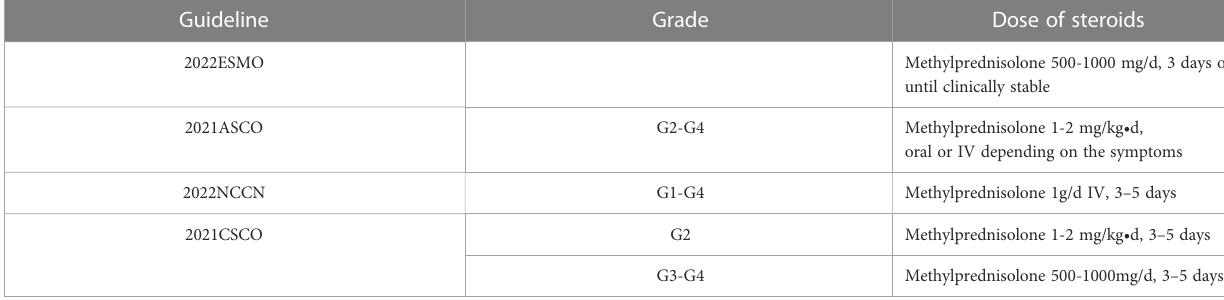
TABLE 2 Recommended doses of glucocorticoids in different